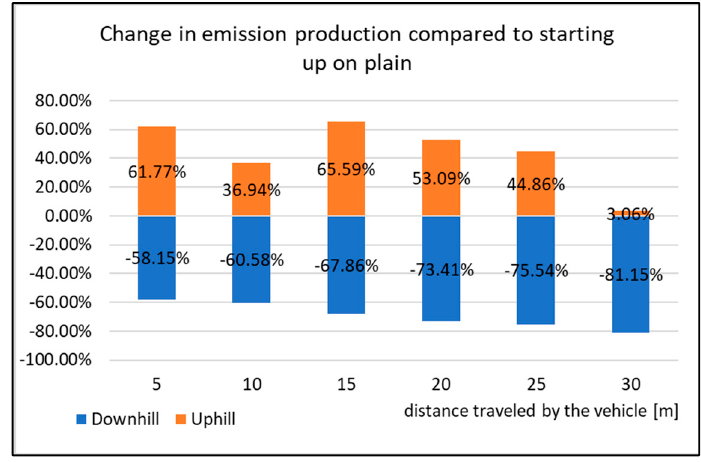
Figure 19. Change in emission production compared to starting up on